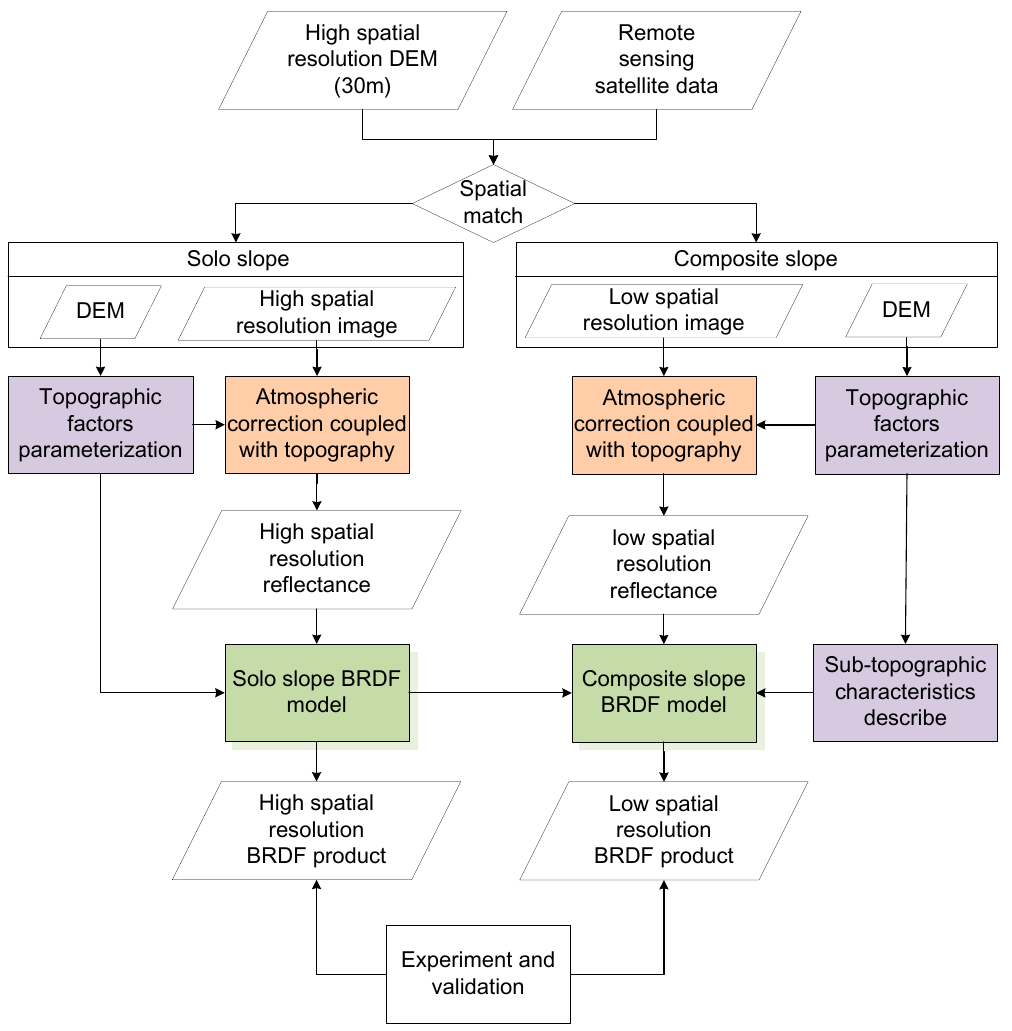
Figure 6. Key procedures of BRDF modeling over rugged terrain.